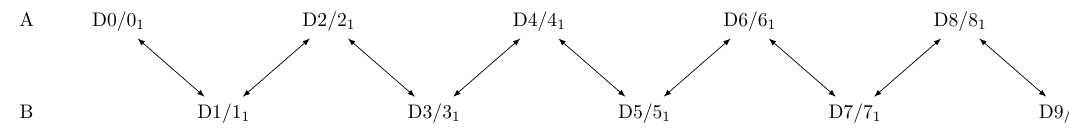
Figure 3 . The T-duality orbit of the D1 = 1 1 .